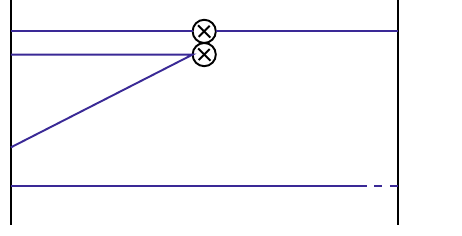
Fig. 1 Four-quark correlation functions F k ; s (left) and the boundary- to-boundary correlators f 1 , k 1 (right), depicted in terms of quark propa- gators. Euclidean time goes from left to right. The double blob indicates